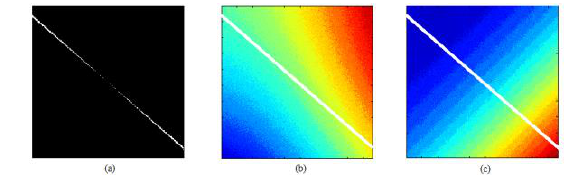
Figure 5. (a). Binary image of the solar meridian. (b) Q image of the polarized skylight. (c) U image of the polarized skylight.